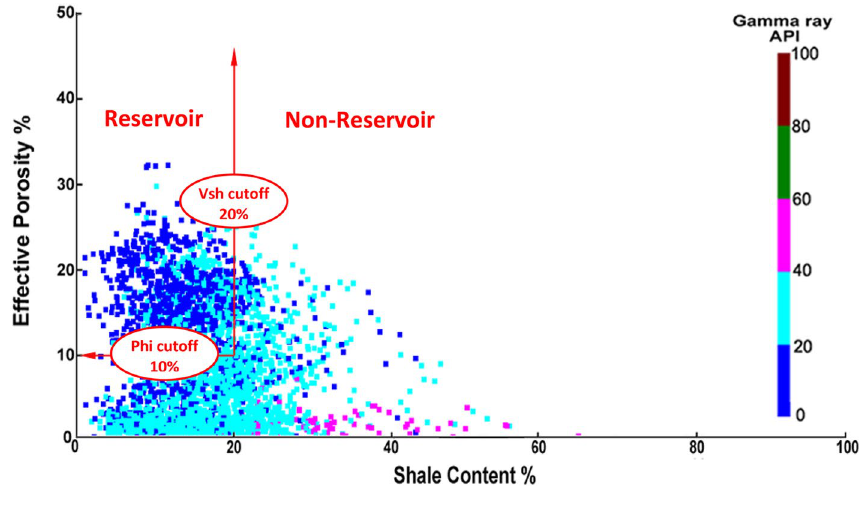
Fig. 13 Effective porosity–water saturation cross-plot accompa- nied with the gamma ray scale for cutoff determination